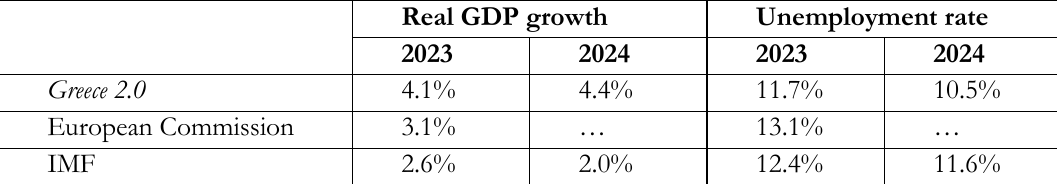
Table 2: Competing forecasts of growth and